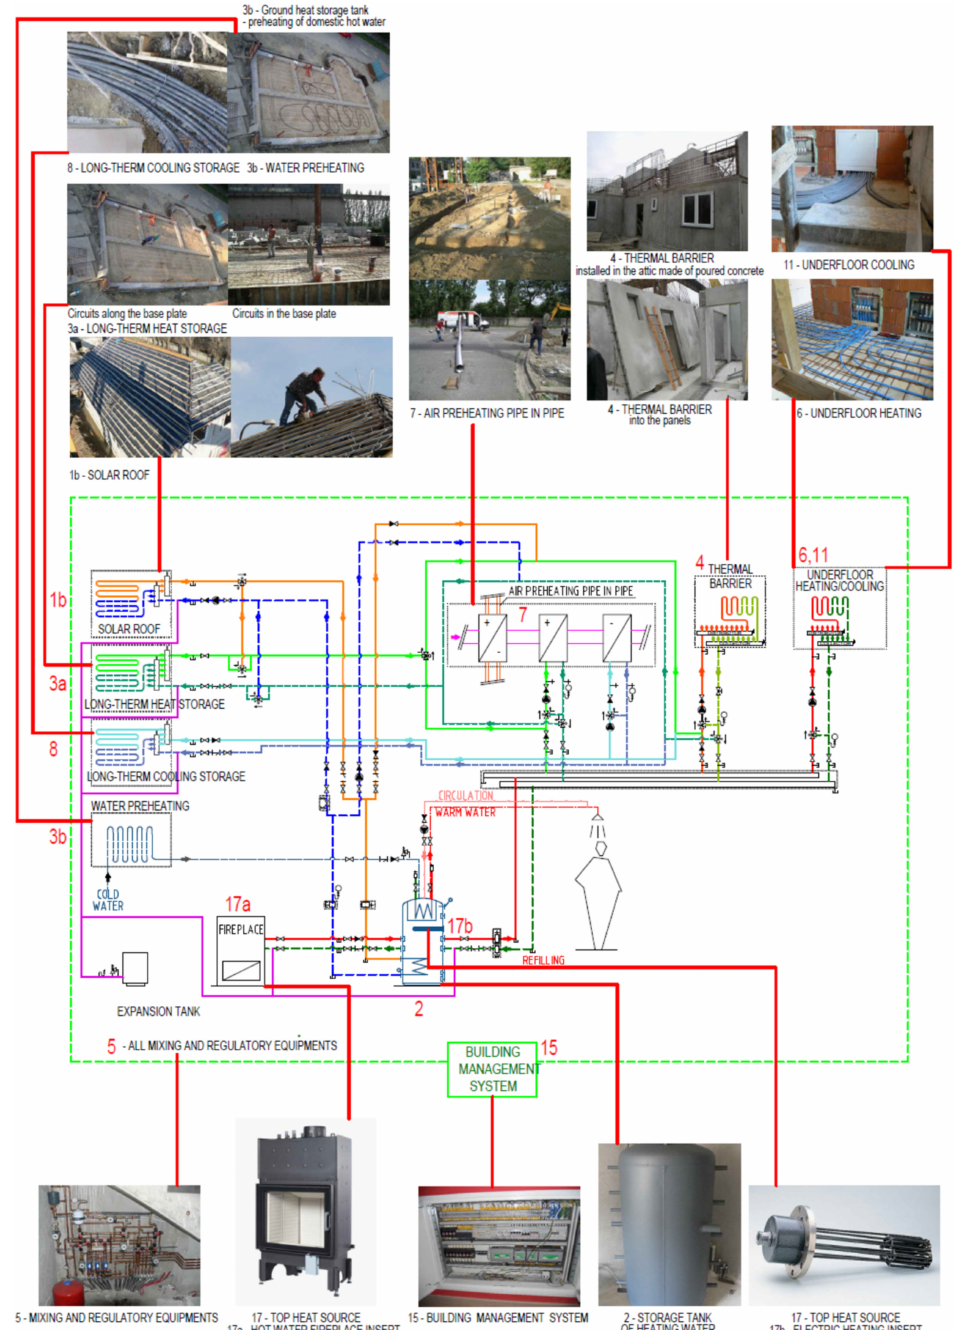
Figure 25. Simplified wiring diagram of the technical solution of the energy systems of the IDA I prefabricated house prototype [13]. 1—solar absorber (energy roof, solar collector, etc.), 2—short-term heat storage, 3—long-term heat storage, 4—active thermal protection circuits (building structure with an internal heat source), 5—mixing and control equipment, 6—low-temperature heating cir- cuits, 7—heat recovery ventilation equipment, 8—cooling circuits located in the ground outside the building, 9—peak cooling source, 10—short-term cold storage, 11—high-temperature cooling circuits, 12—waste heat from the drainage system, 13—waste heat from the technological process, 14—electricity generation equipment (photovoltaics, wind power plant, etc.), 15—building control system, 16—batteries for storing electricity, 17—top heat source. (Note: The description of the numerical items is identical to the devices in Figure 6 and in Section